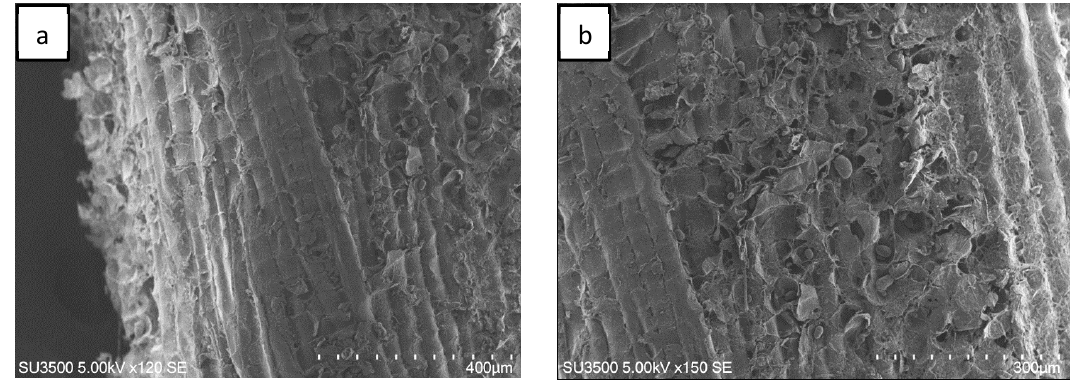
Figure 2. SEM image of sago fiber showing a bundled of fiber. ( a ) The side view shows a rough surface of the fiber. ( b ) The sago fiber contains granules of starch and fine fibers.